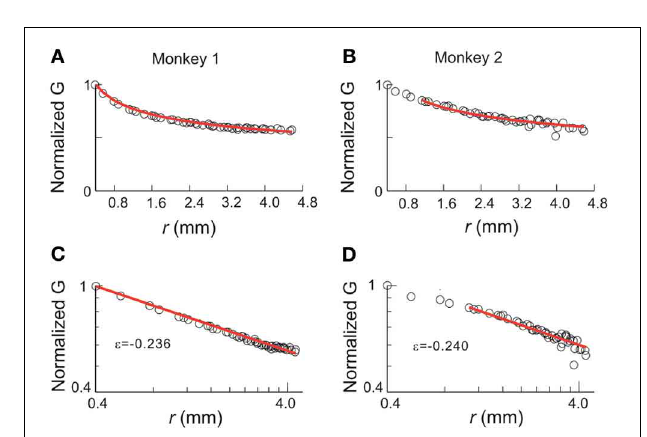
FIGURE 10 | Correlation function for avalanche activities. Pair-wise covariance, G , of nLFP activities is plotted against the physical distance between the corresponding recording sites. (A,B) Linear coordinates. (C,D) Double-logarithmic coordinates. G is normalized by the value of the G (0.4), i.e., the covariance with the nearest neighbor. In all panels, the data are represented by circles and red lines indicate the best power law fit. The range of power-law fitting is either all possible distances (monkey 1) or r > 1mm (monkey 2). ε , the exponent of the best fitting power